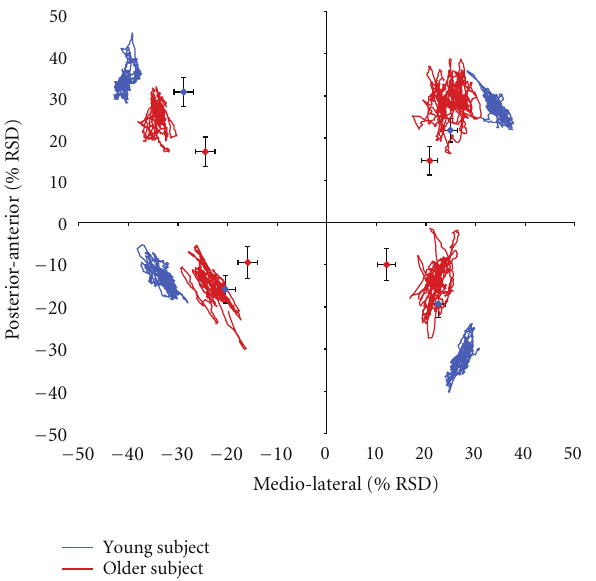
Figure 1: Single-subject data of a young subject (32 years) and an older subject (70 years) depicted as statokinesigram (blue and red lines) for subtest 4 (shifting the COP to the upper right), subtest 5 (shifting the COP to the upper left), subtest 6 (shifting the COP to the lower right), and subtest 7 (shifting the COP to the lower left). Group data for young ( N = 24) and older subjects ( N = 21) are displayed by blue and red diamonds in the respective sectors of the diagram. COP deviations are given in percent changes of raw sensor data (RSD) in relation to origin of the coordinate system. Standard deviations of the average COP-positions (black bars) are given for medio-lateral and anterior-posterior directions.